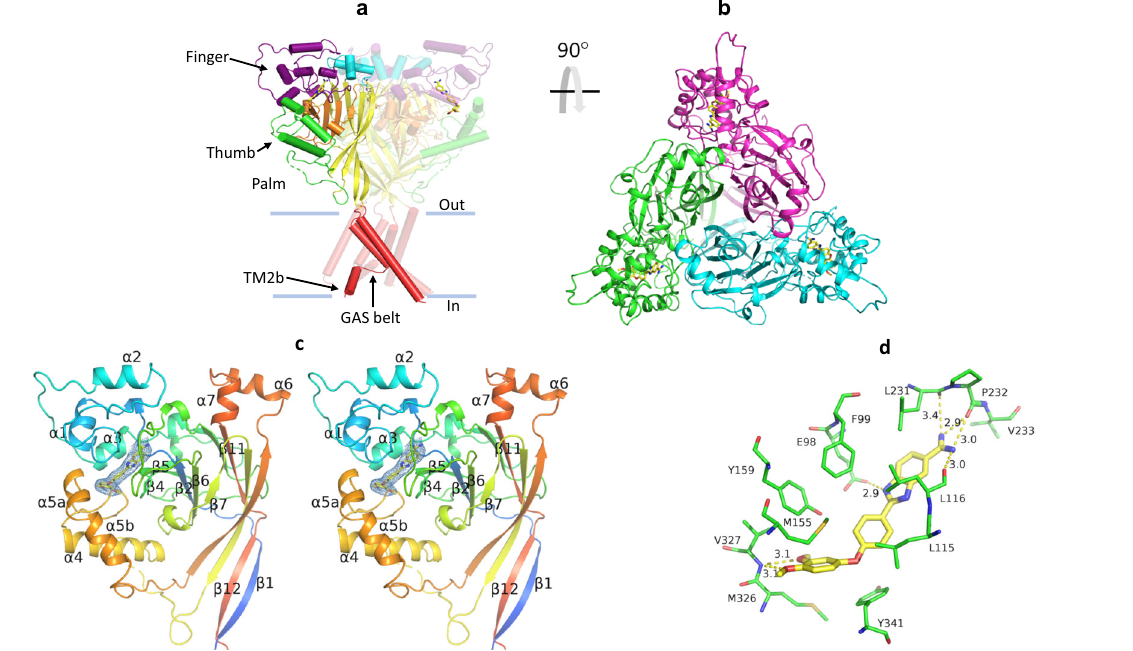
Fig. 8 Crystal structure of the Δ ASIC1/JNJ-799760 complex. a Architecture of Δ ASIC1/JNJ-799760 viewed parallel to the membrane. One subunit is highlighted with a different color for each domain. JNJ-799760 is in yellow. b The same structure viewed extracellularly with each subunit in a different color. c Stereo view of the JNJ-799760-bound ECD (chain A). Key α helixes and β sheets are labeled. The 2Fo − Fc electron density map of JNJ-799760 contoured at 1.0 σ is shown as blue mesh. d Stick representation of JNJ-799760 and the surrounding channel residues in the binding pocket (chain A). Numbers next to the dotted lines indicate distances (in Å). Oxygen and nitrogen atoms are shown in red and blue,